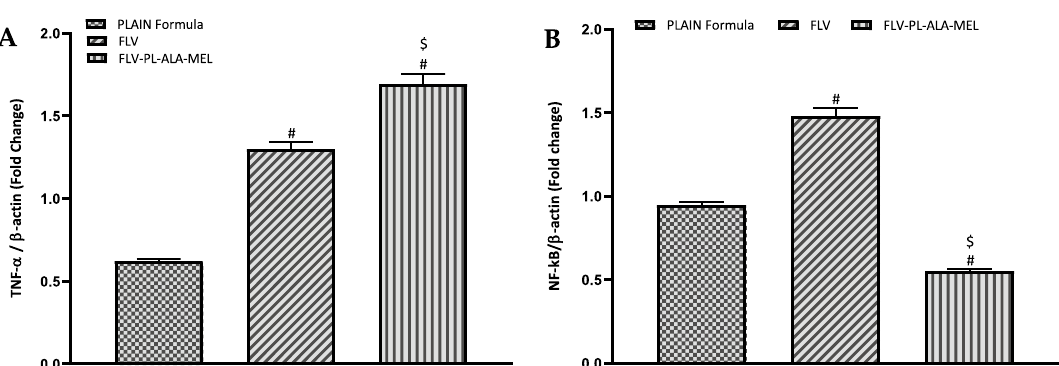
Figure 8. Expression of apoptotic markers ( A ) Bax, ( B ) Bcl-2 ( C ) caspase-3, and ( D ). p53 within Caco2 cells. Data denote the mean of four independent experiments ± SD. With a view to making more than one comparison, we used the Tukey post hoc test. # Significantly different versus plain formula (p < 0.05). *Significantly different versus control (p < 0.05). $ Significantly different versus FLV-R (p < 0.05).